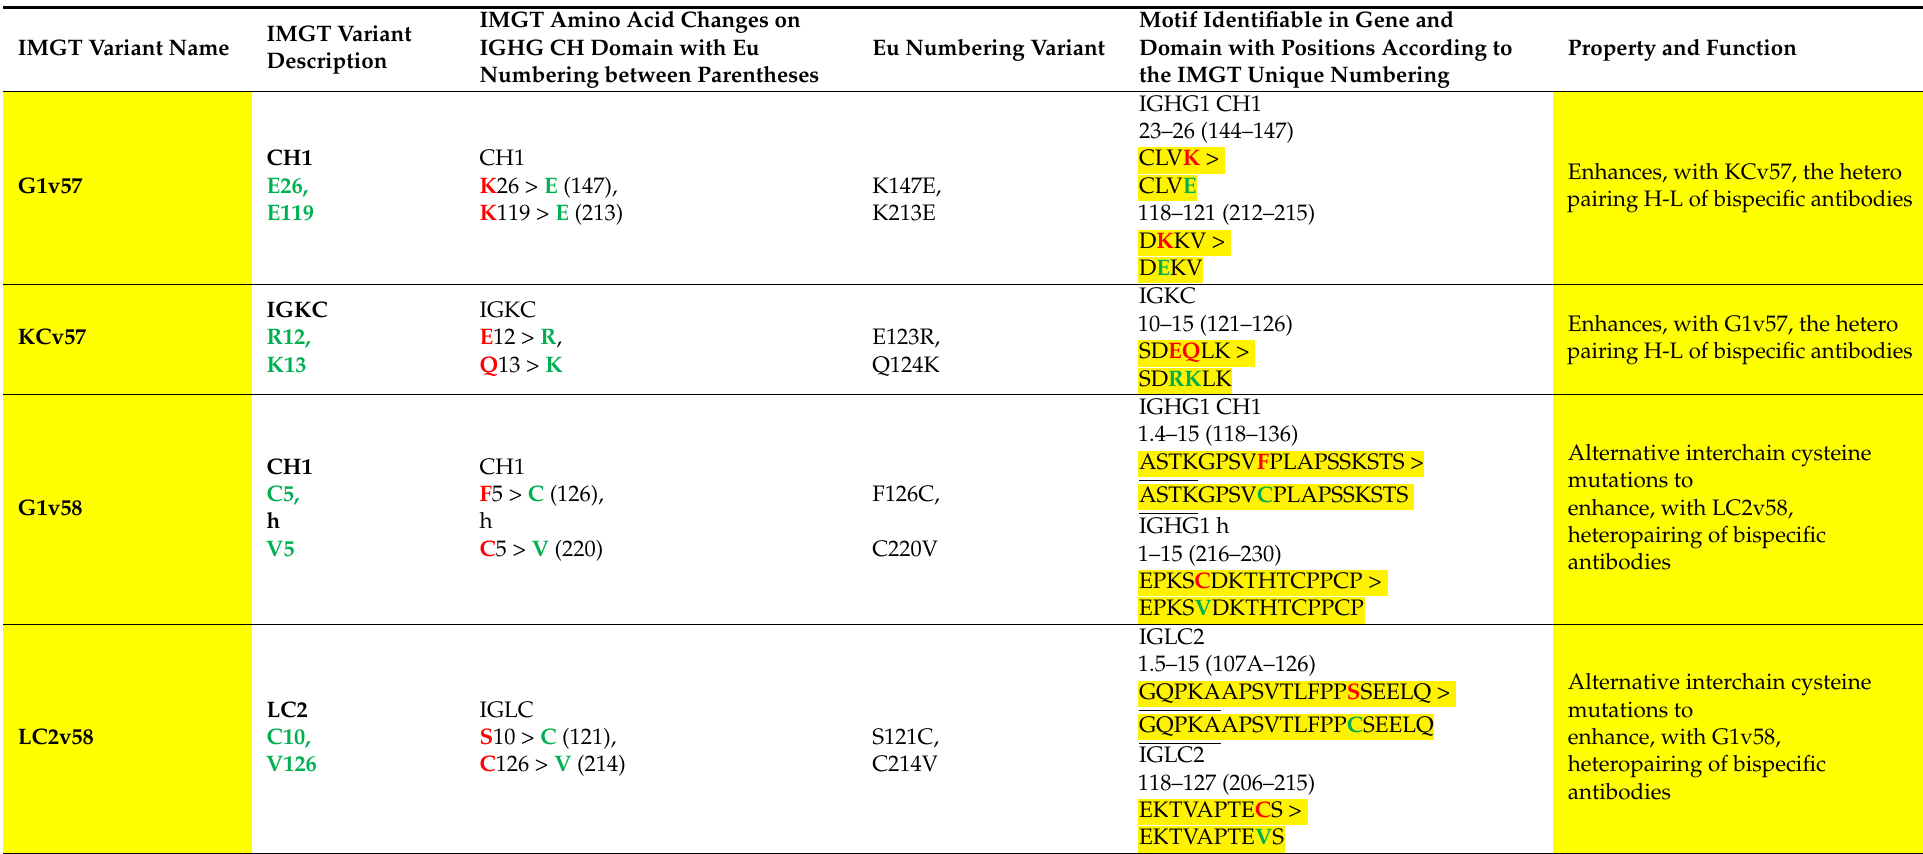
Table 21. IMGT nomenclature, Eu positions and IMGT motif of engineered Fc variants involved in the enhancement of hetero pairing H-L of bispecific antibodies (Structure